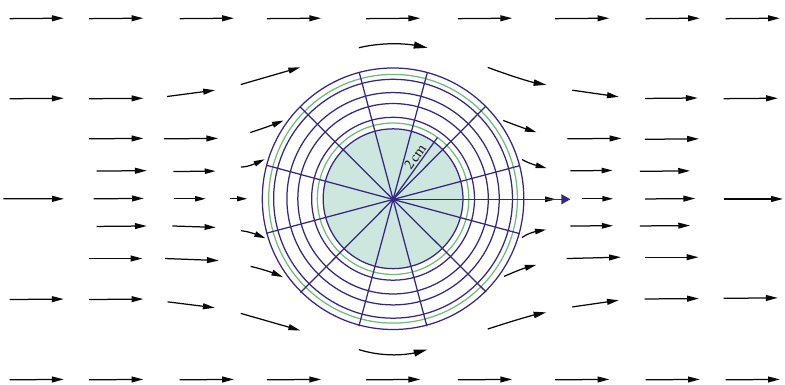
Figure 9: Finite difference grid in the polar coordinate system, reprinted from ref. [11], copyright 2017 with permission from Springer Nature.